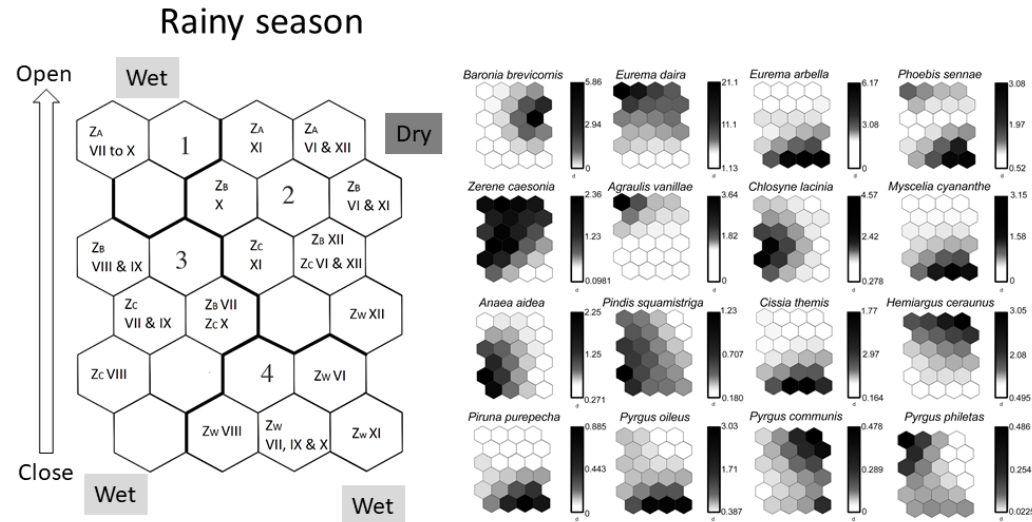
Figure 2. Probabilities of occurrence and distribution (SOM) of sampled Lepidoptera for rainy season. Left side: Kohonen (SOM) map for the four studied sites (2 years of sampling). Four clusters can be distinguished. Cluster 1: humid + open field; Cluster 3: humid + shrubs; Cluster 4: humid + conserved forest; Cluster 2: driest months of the rain season independent of type of habitat. Roman numerals are months, from I = January to XII = December). Zones A to W are noted Za to Zw. Right side: Gradient analysis of the abundance of Lepidoptera on the trained SOM represented by a shaded scale (dark = high abundance, light = low abundance). Each small map representing species can be compared to (or superimposed on) the map of Kohonen, thus showing the distribution patterns of the various taxa (in shades of gray) within each subarea of the SOM. Generalist species are indicated when SOM patterns are almost black. On the right of each map, the relative scale of occurrence probabilities is shown.